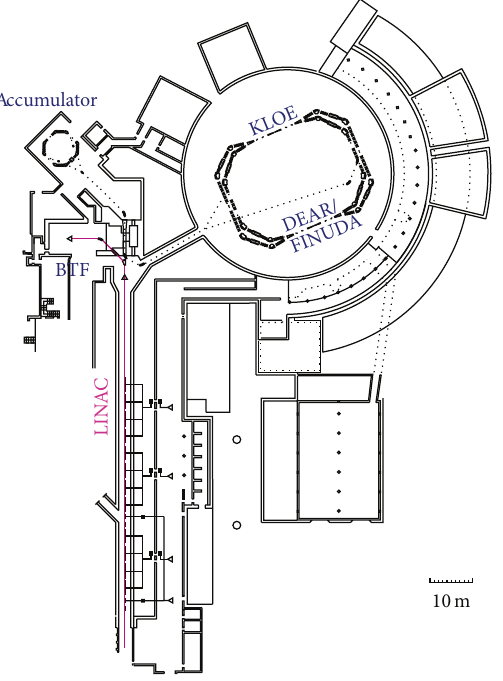
Figure 4: Layout of the DA Φ NE complex at Laboratori Nazionali di Frascati,